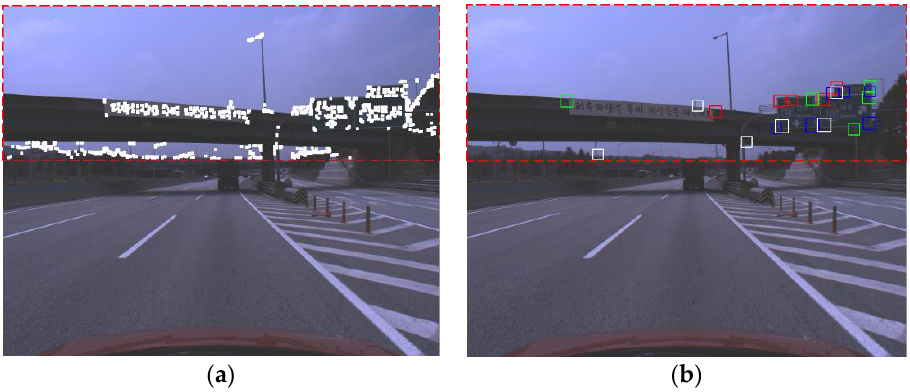
Figure 5. Example of an ROI for corner HG and corner hypotheses. ( a ) ROI for corner HG, ( b ) corner hypotheses generated by a VJ detector.